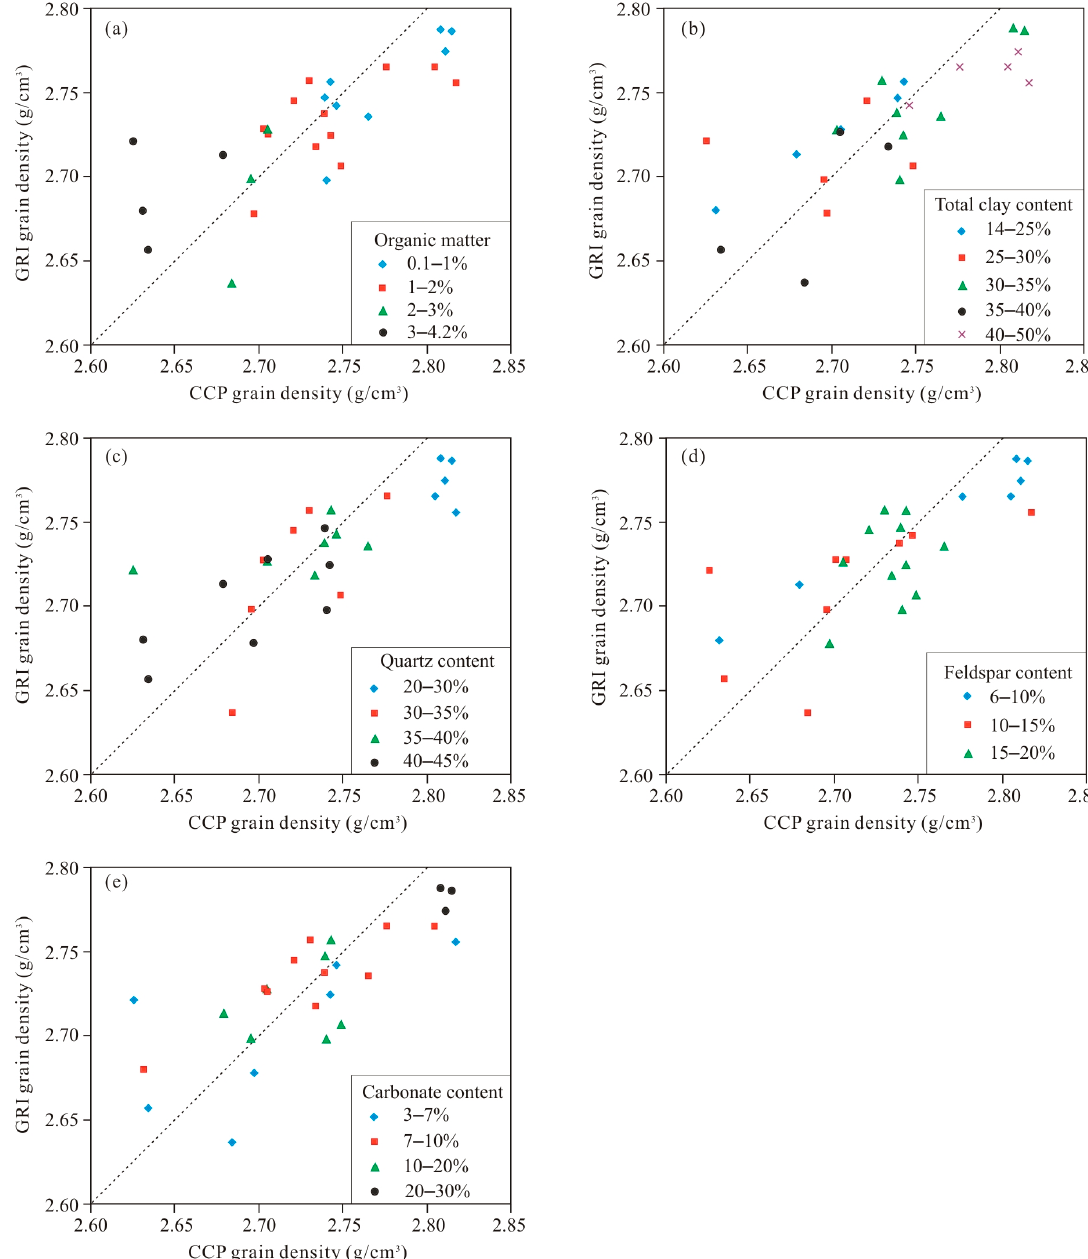
Figure 4. Comparison of the CCP grain density and GRI grain density values (variance σ 2 = 0.0012 ): ( a ) clay content, ( b ) organic matter content, ( c ) quartz content, ( d ) feldspar content, ( e ) carbonate content.